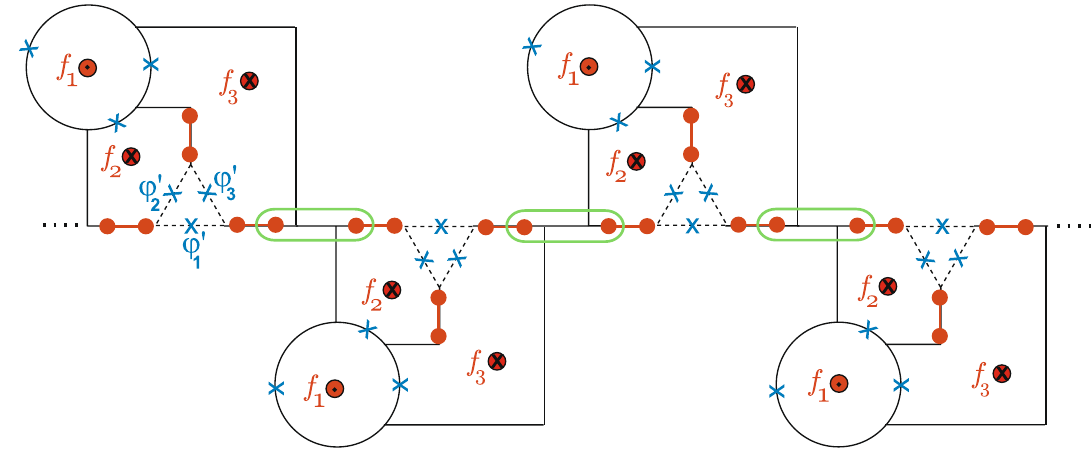
Figure 5. A scalable design for a superconducting circuit with MZMs. Two MZMs in each circuit of Fig. 4a can be coupled in the green box to form a one-dimensional lattice